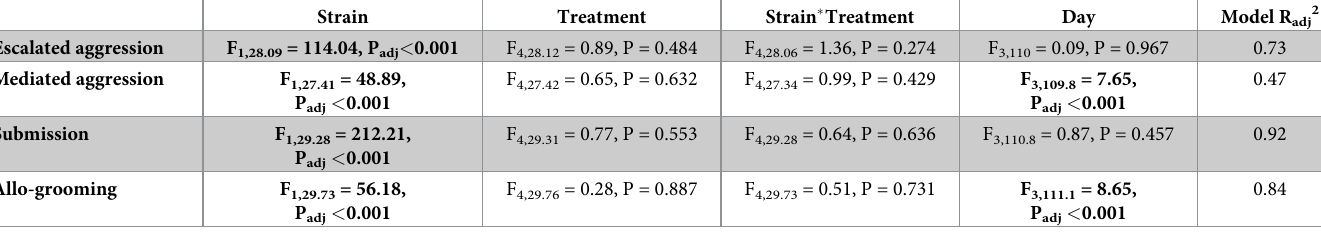
Table 3. Fixed effects and model R adj2 for each behavior measured across the study week (N = 154).